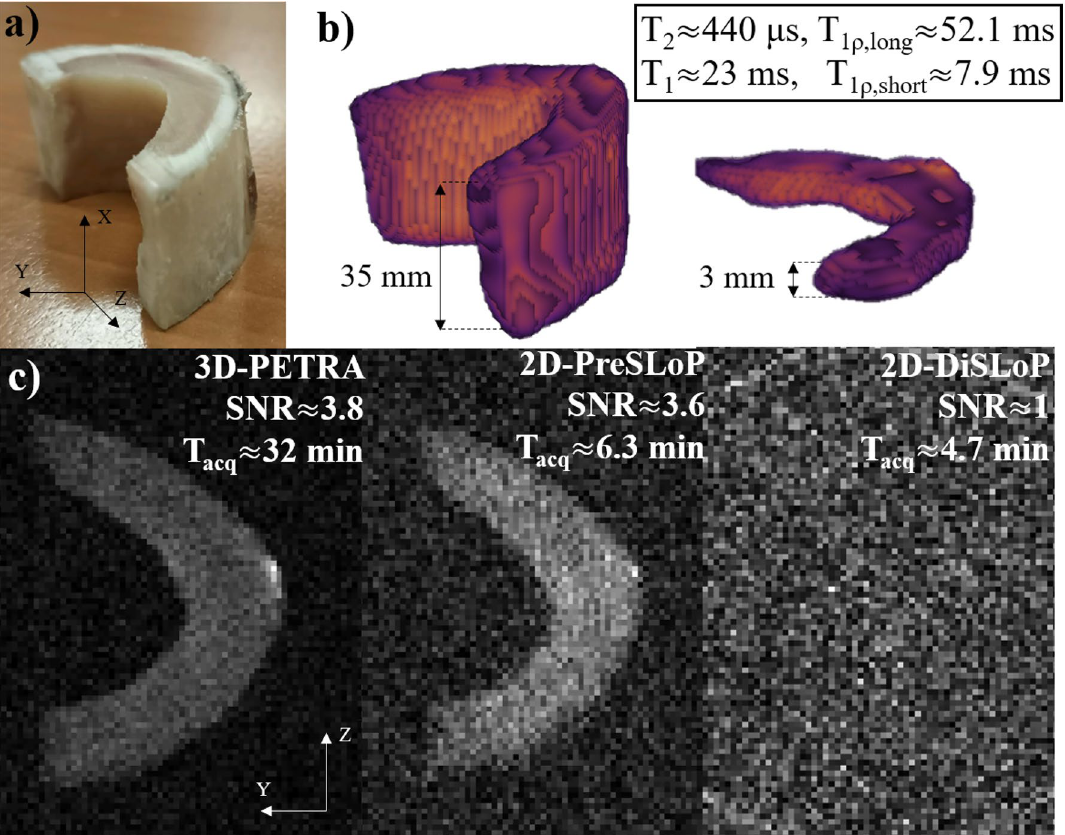
Figure 4. Performance of DiSLoP and PreSLoP for an ultra-short T 2 biological tissue (cortical bone). ( a ) Photograph of bovine femur sample. ( b ) 3D-PETRA (left) and 3D-PreSLoP (right). ( c ) 2D images for PETRA (left) with slice resolution ≈ 3 mm, PreSLoP (middle) and DiSLoP (right) with (cid:31) z ≈ 3 mm. We provide T 1 ρ for both tissues, and the average T 1 and T 2 values (see Tab.